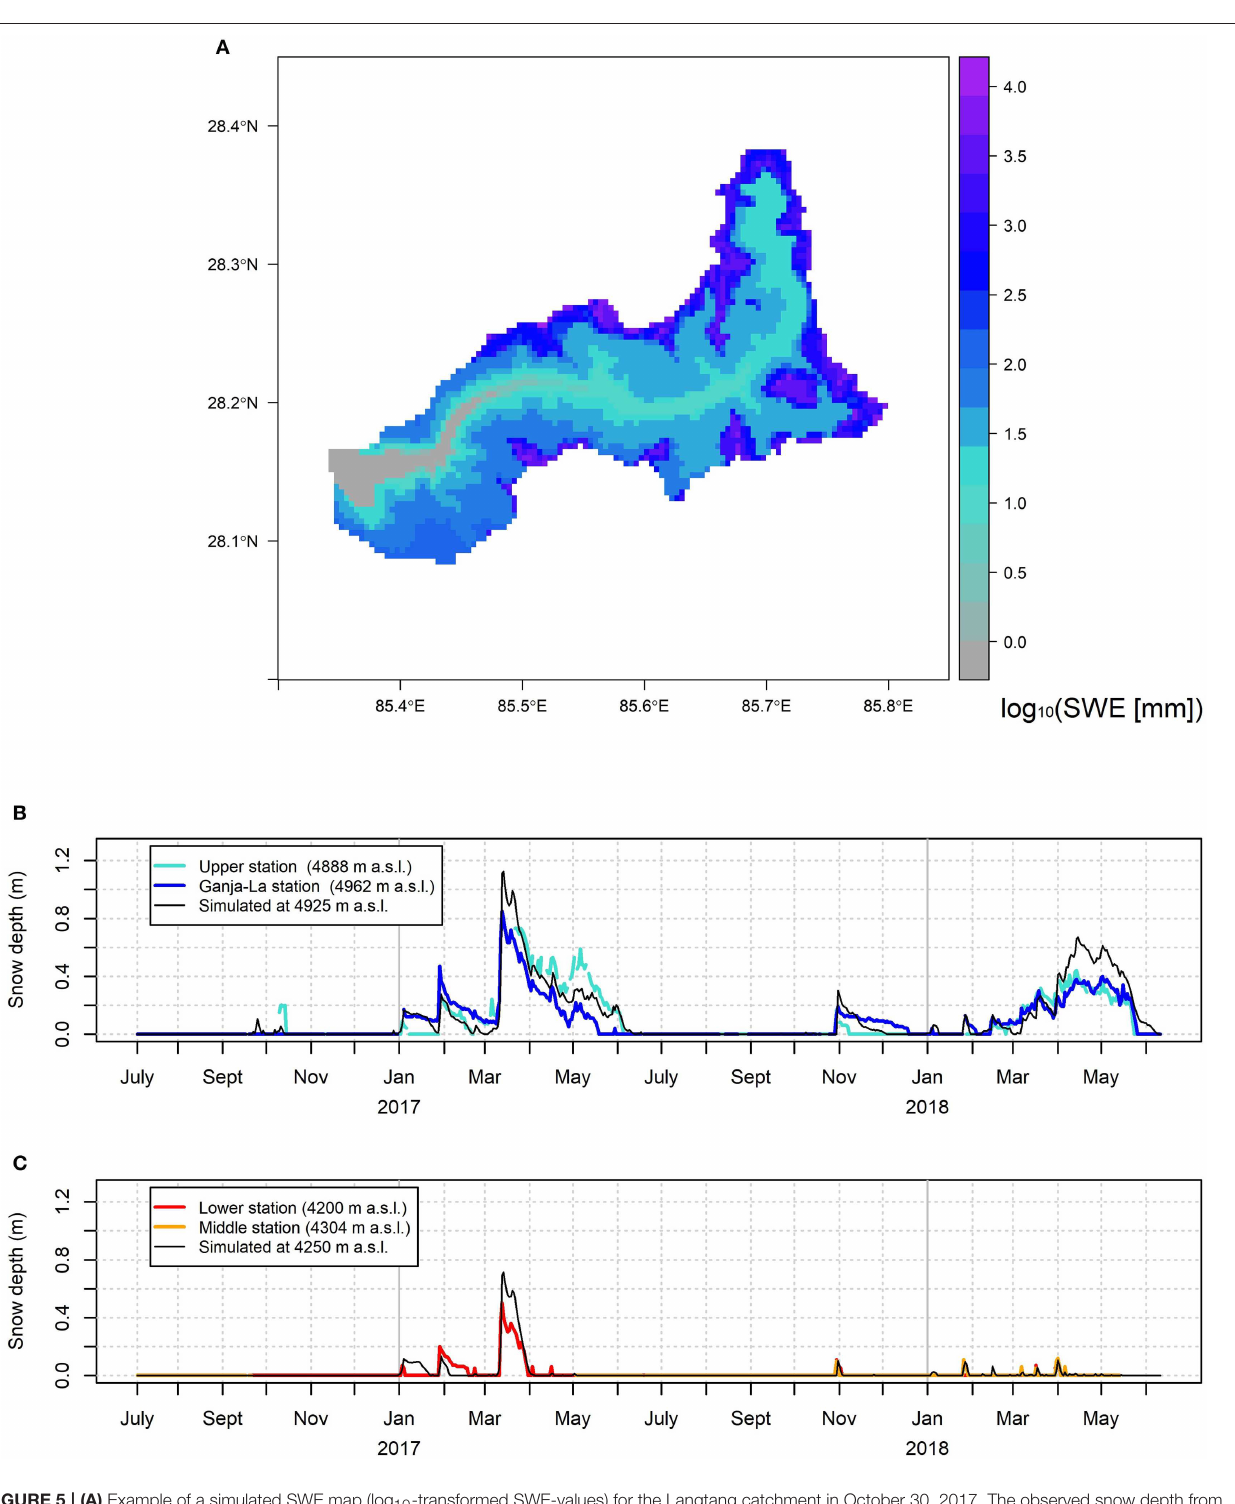
FIGURE 5 | (A) Example of a simulated SWE map (log 10 -transformed SWE-values) for the Langtang catchment in October 30, 2017. The observed snow depth from July 2016 to June 2018 (B) at the Upper and Ganja La stations and (C) at Lower and Middle stations. The simulated snow depth in a grid cell between the station-pairs is shown by black